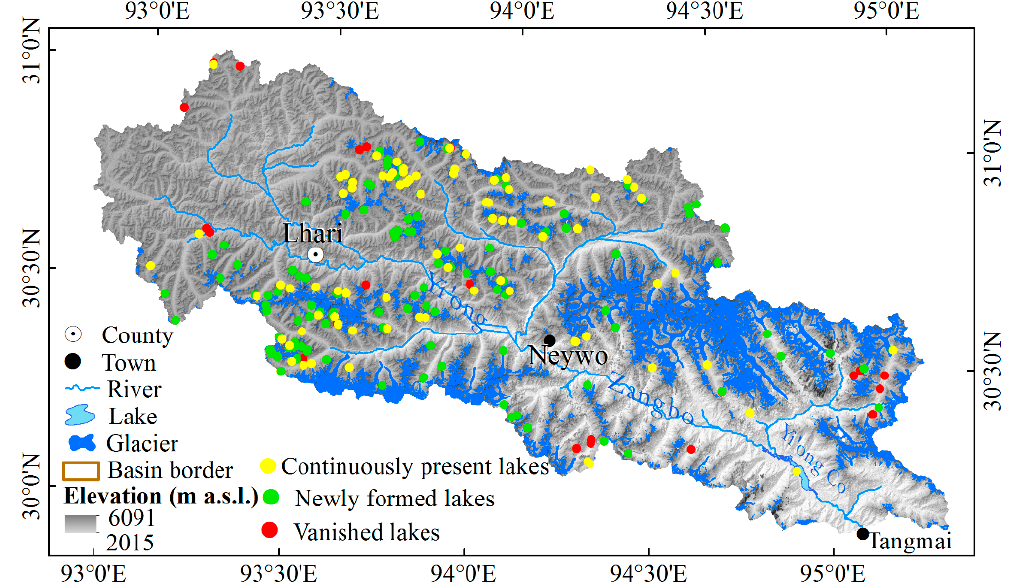
Figure 5. The distribution of newly formed, vanished, and continuously present glacial lakes in the Yi’ong Zangbo River Basin in 1970–2016.